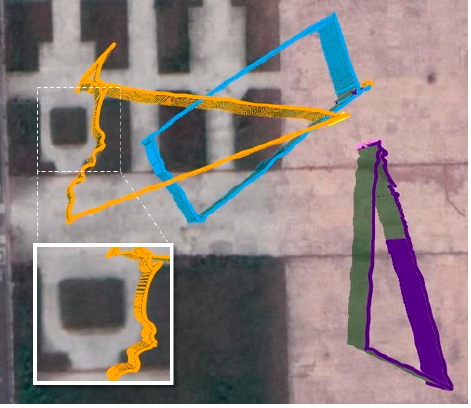
Figure 24. Flight trajectory log of the first experiment.